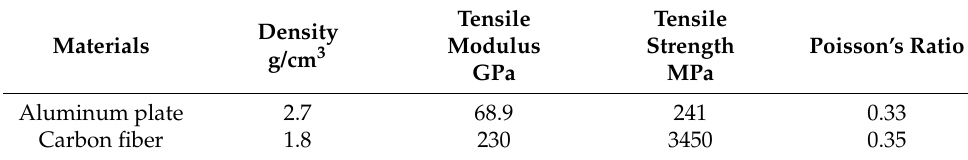
Table 5. Isotropic properties of aluminum and carbon fiber.